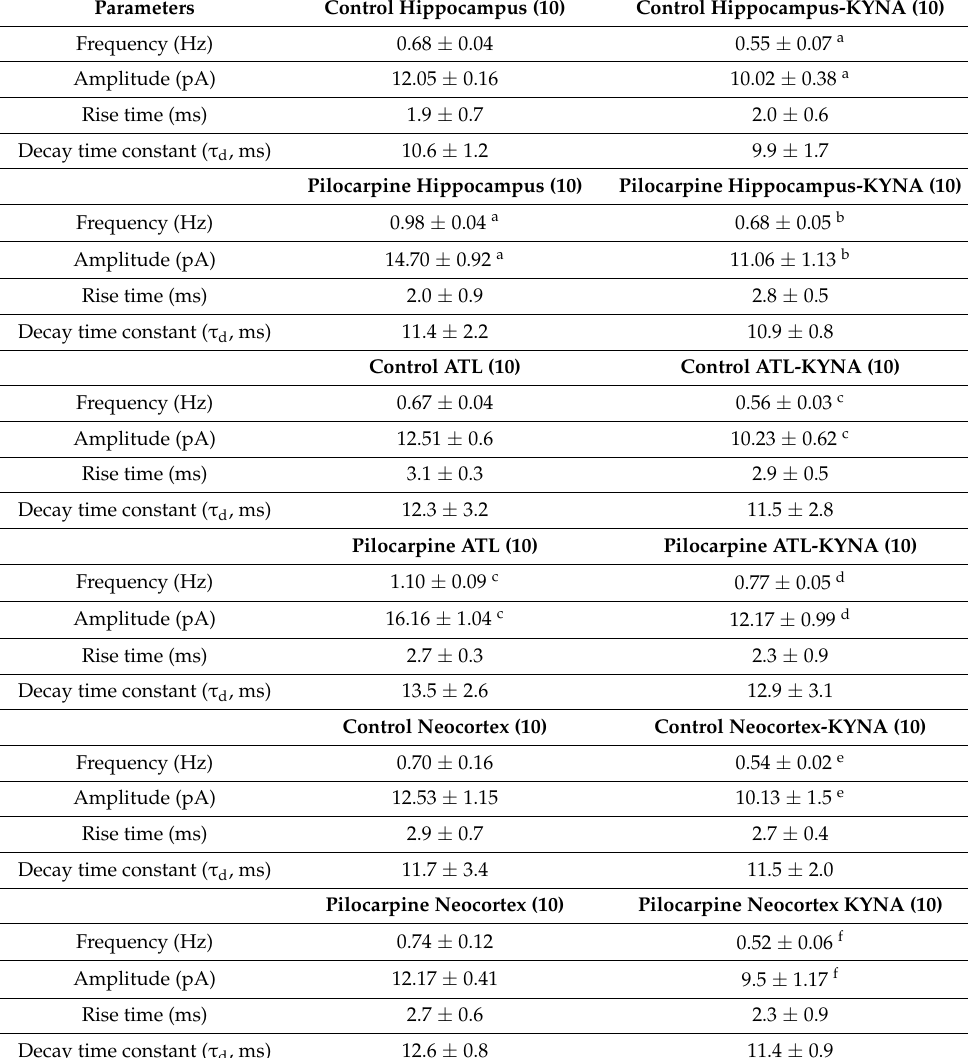
Table 1. Characteristics of EPSCs (frequency, amplitude, rise time, and decay time constant) recorded from pyramidal neurons in hippocampal, ATL, and neocortical samples before and after 30 min perfu- sion with 10 micro molar kynurenic acid. ‘a’ significant difference with respect to control hippocampus, ‘b’ significant difference with respect to pilocarpine hippocampus, ‘c’ significant difference with respect to control ATL, ‘d’ significant difference with respect to pilocarpine ATL, ‘e’ significant difference with respect to control neocortex, ‘f’ significant difference with respect to pilocarpine neocortex. Data represented as mean ± SEM; Single digit denotes p < 0.05. Mann–Whitney U